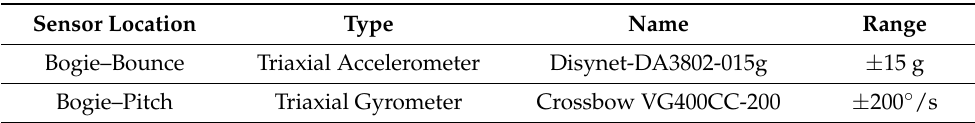
Figure 8. The measurement set up: ( a ) the train, ( b ) the instrumentation. Table 3. Properties of sensors.